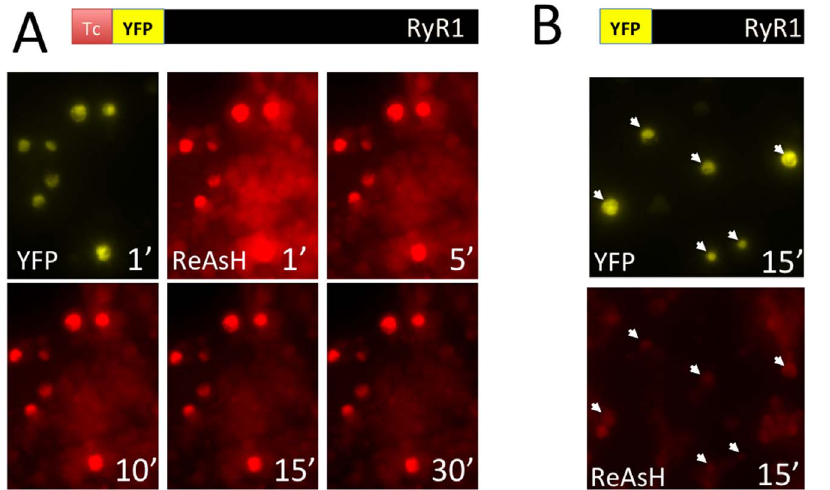
Figure 2. Removal of nonspecific ReAsH labeling using BAL. (A) HEK-293T cells expressing FLN(YFP)RyR1 labeled with ReAsH were incubated with 0.25 mM BAL. YFP (top left panel) or ReAsH fluorescence (subsequent panels) was recorded at the timepoints indicated after addition of BAL. Colocalization of YFP and ReAsH in these cells was plainly evident after 10 9 incubation in BAL. (B) YFP (top panel) and ReAsH fluorescence (bottom) for ReAsH-treated HEK-293T cells expressing (YFP)RyR1 (which lacks a Tc tag) were recorded 15 9 after treatment with 0.25 mM BAL. No specific YFP/ ReAsH colocalization was observed. Arrows indicate same cells in both images in (B).